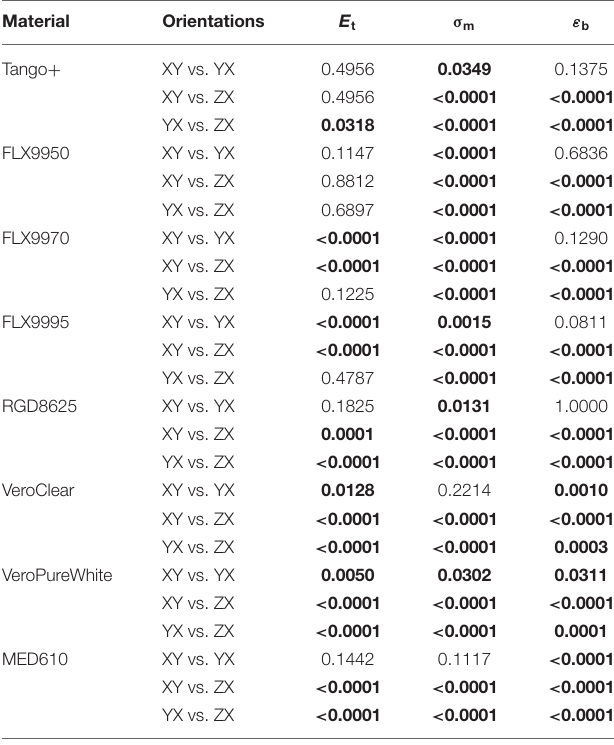
TABLE 3 | p -Values of the multiple comparison tests with Bonferroni correction ( E t , tensile modulus; σ m , tensile strength; ε b , elongation at break).